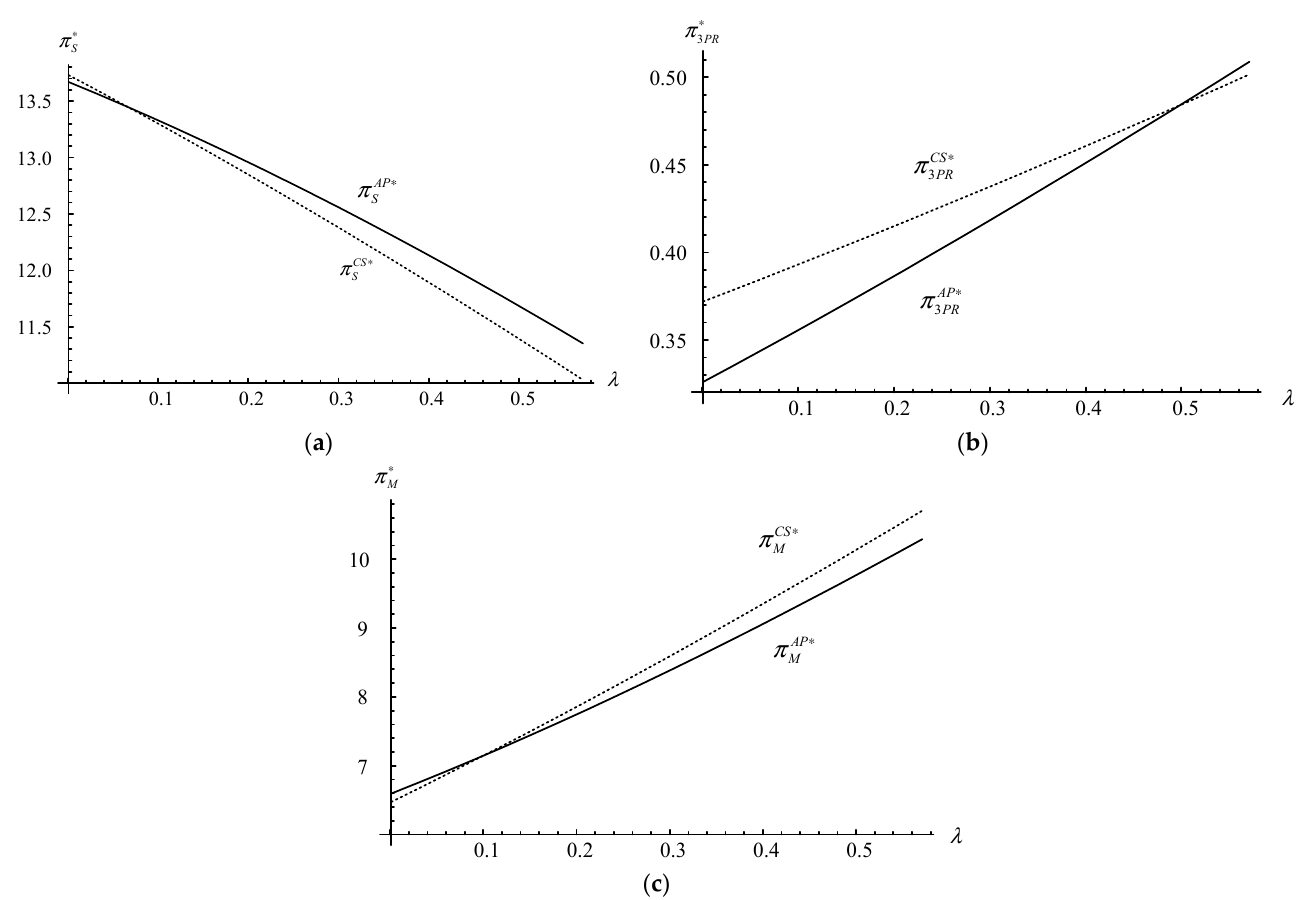
Figure 5. The firms’ profits vs. the disassembly rate. ( a ) The supplier’s profit vs. the disassembly rate. ( b ) The 3PR’s profit vs. the disassembly rate. ( c ) The manufacturer’s profit vs. the disassembly